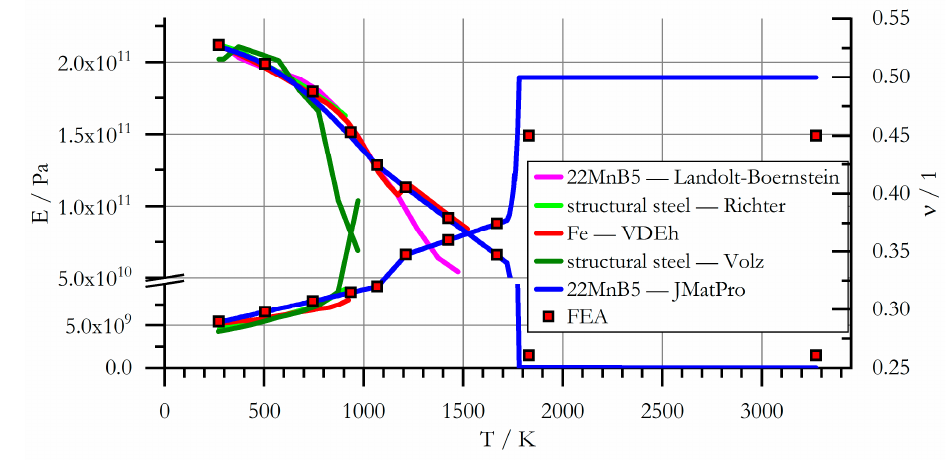
Figure 6. Elastic modulus and Poisson ratio of 22MnB5.